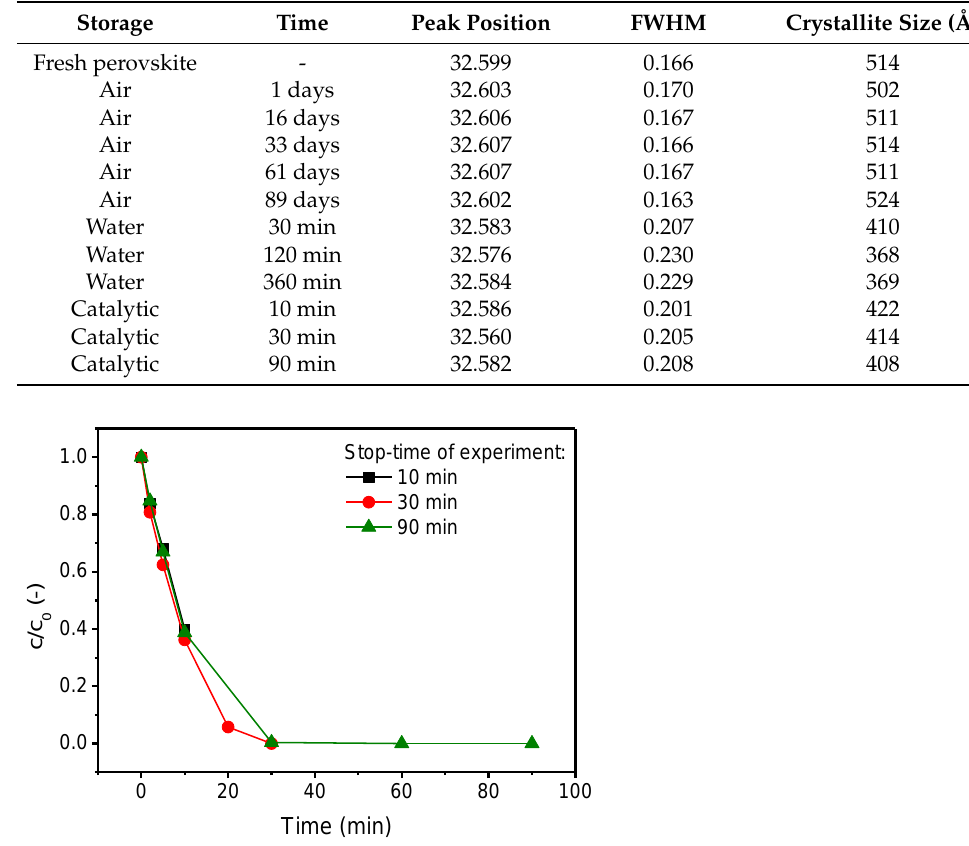
Figure 2. Relative concentration of bisphenol A plotted against time during catalytic degradation using SCF. Three different experiments stopped after different times to collect SCF after different times of use as catalysts. Concentrations are based on HPLC analyses.